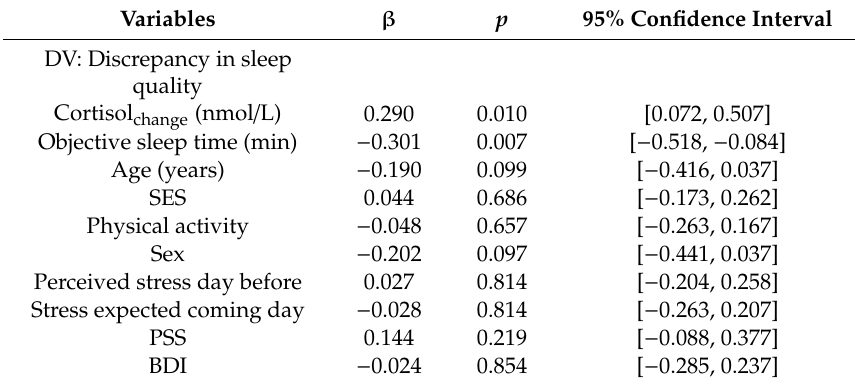
Table 3. Relationship between Cortisol change and the discrepancy between subjective and objective sleep